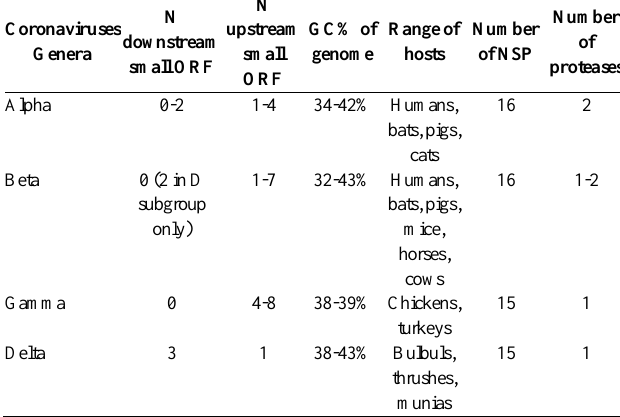
Table 1: Overall structural features of four Coronaviruses genera Coronaviruses